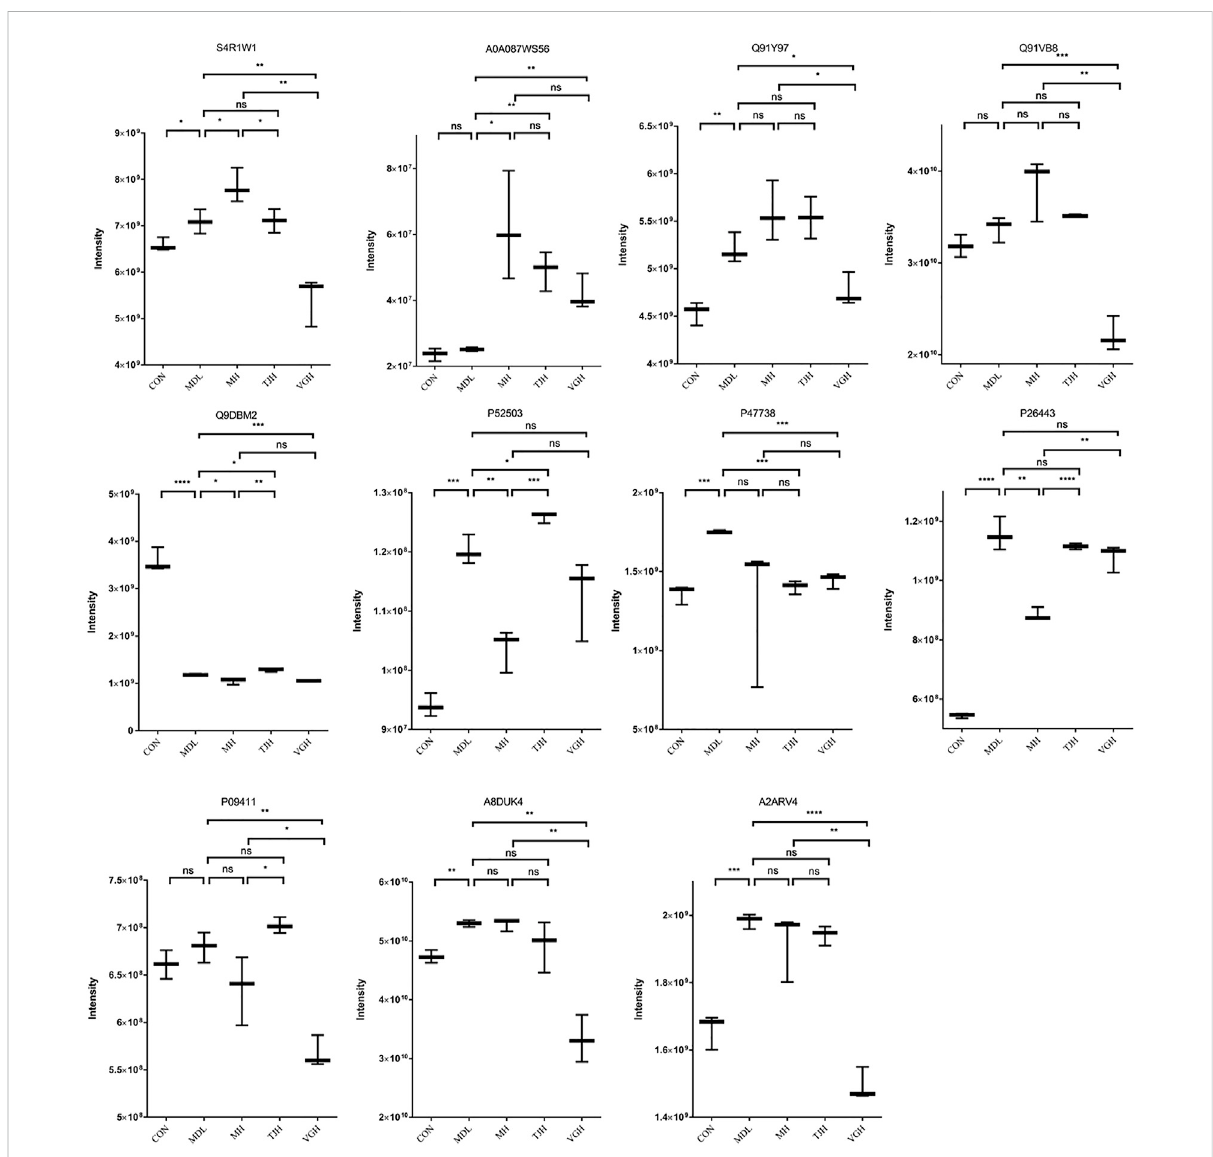
FIGURE 6 Quantitative comparison of target proteins. (ns: P ＞ 0.05, not signi fi cant; # p < 0.05; ## p < 0.01; ### p < 0.001: models vs. control; *: p < 0.05; **: p < 0.01; ***: p < 0.001; ****: p < 0.0001)